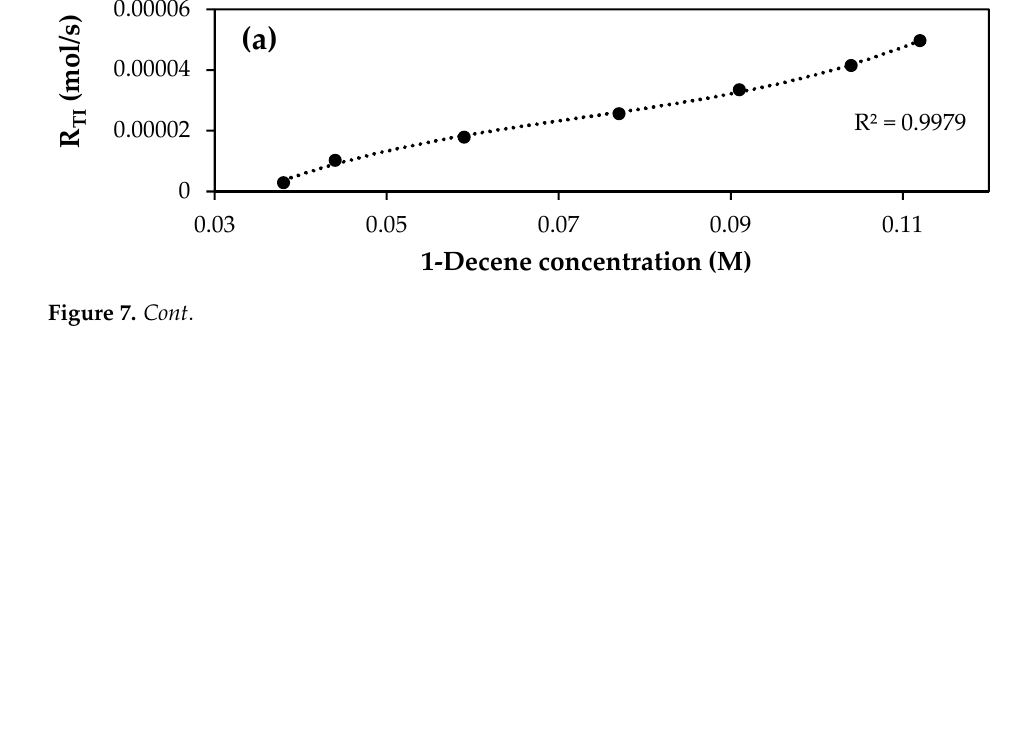
Figure 6. Fitting of the proposed dimerization rate equation with experimental data at ( a ) 423 K, ( b ) 443 K and ( c ) 483 K. Experimental data are plotted as symbol and calculated data are plotted as dash line.